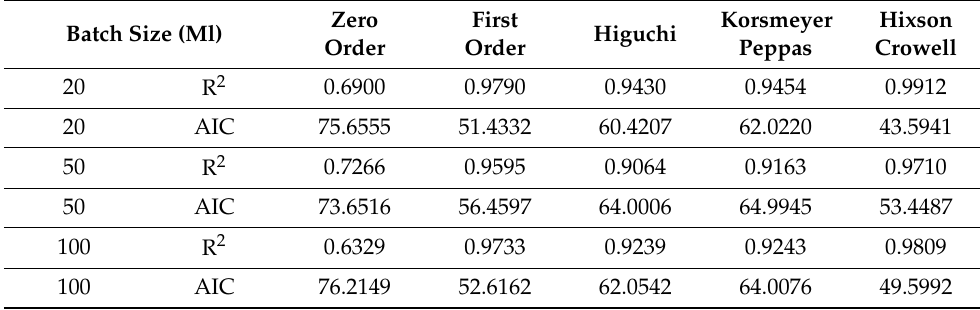
Figure 7. In vitro comparative drug release profile of CF018 emulsion (20, 50 and 100 mL) and free drug. Table 3. Release kinetics data of DTB-loaded emulsion.